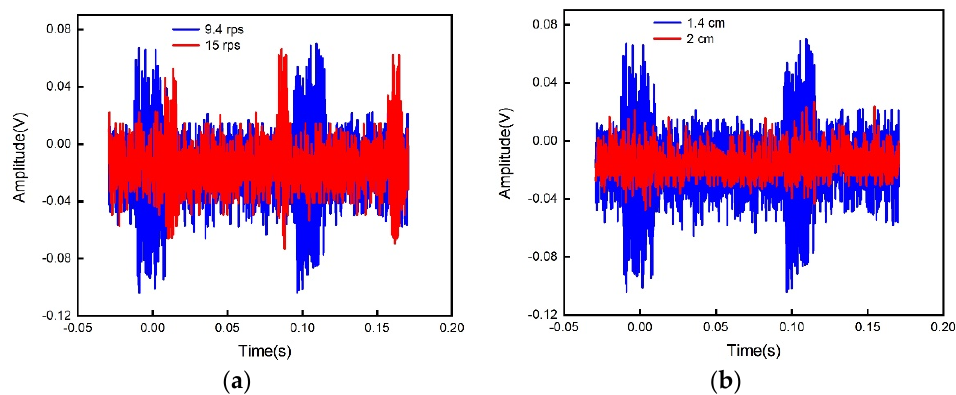
Figure 7. The measured original modulation signal waveform: ( a ) the measured voltage signal as a function of time at different rotational speeds; ( b ) the measured voltage signal as a function of time under different coaxial coupling distances.